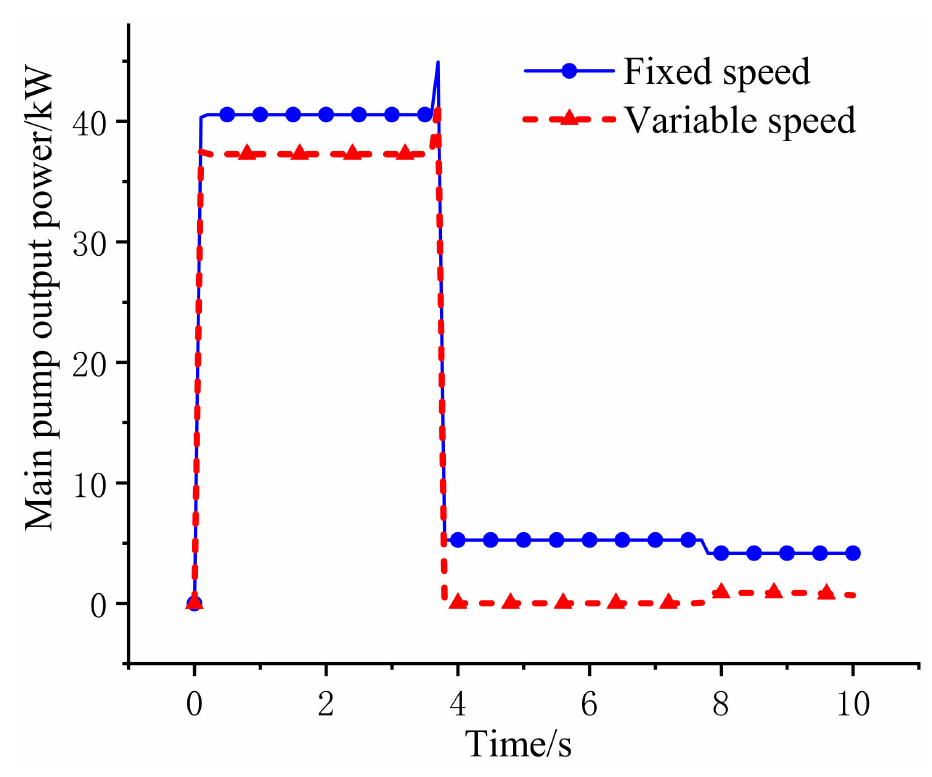
Figure 16. Output power curve of main pump under the constant/variable speed